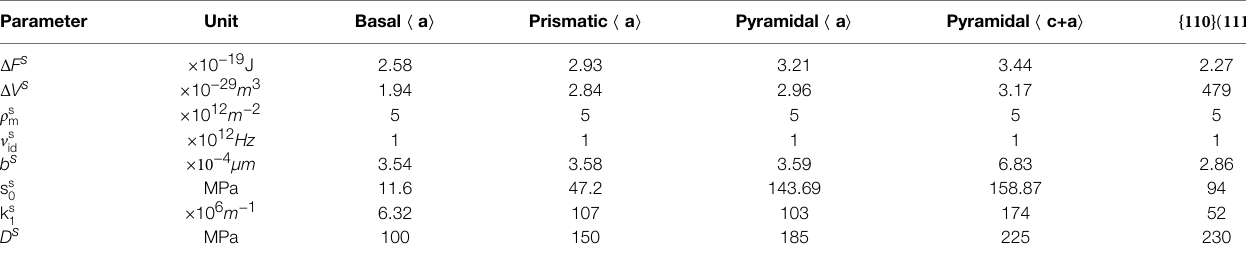
TABLE 6 | Flow rule parameters for HCP and BCC crystals. Parameter